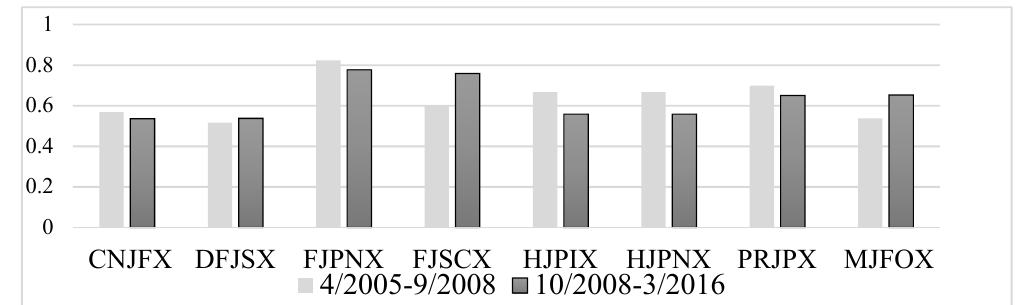
Figure 2 . Systematic risk (beta; in absolute terms) (benchmark: TOPIX).